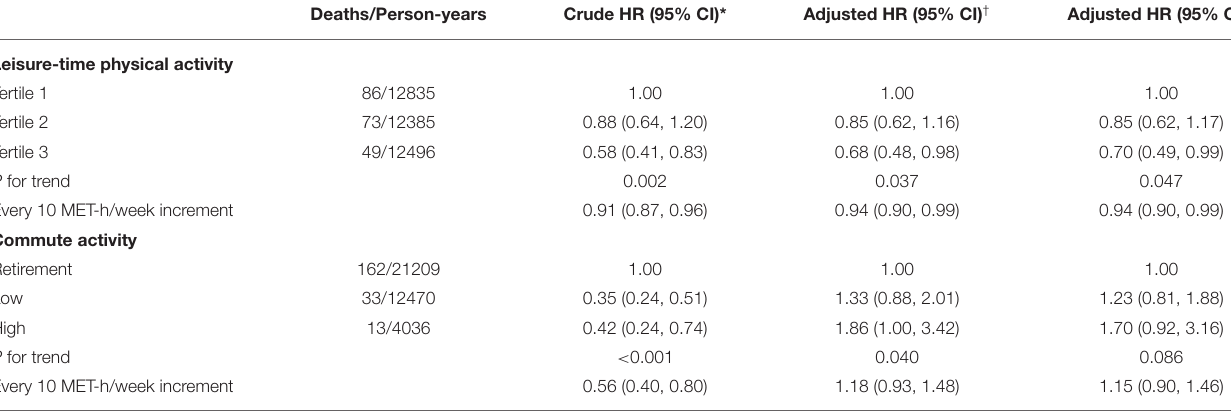
TABLE 3 | Associations of all-cause mortality with leisure-time physical activity and commute physical